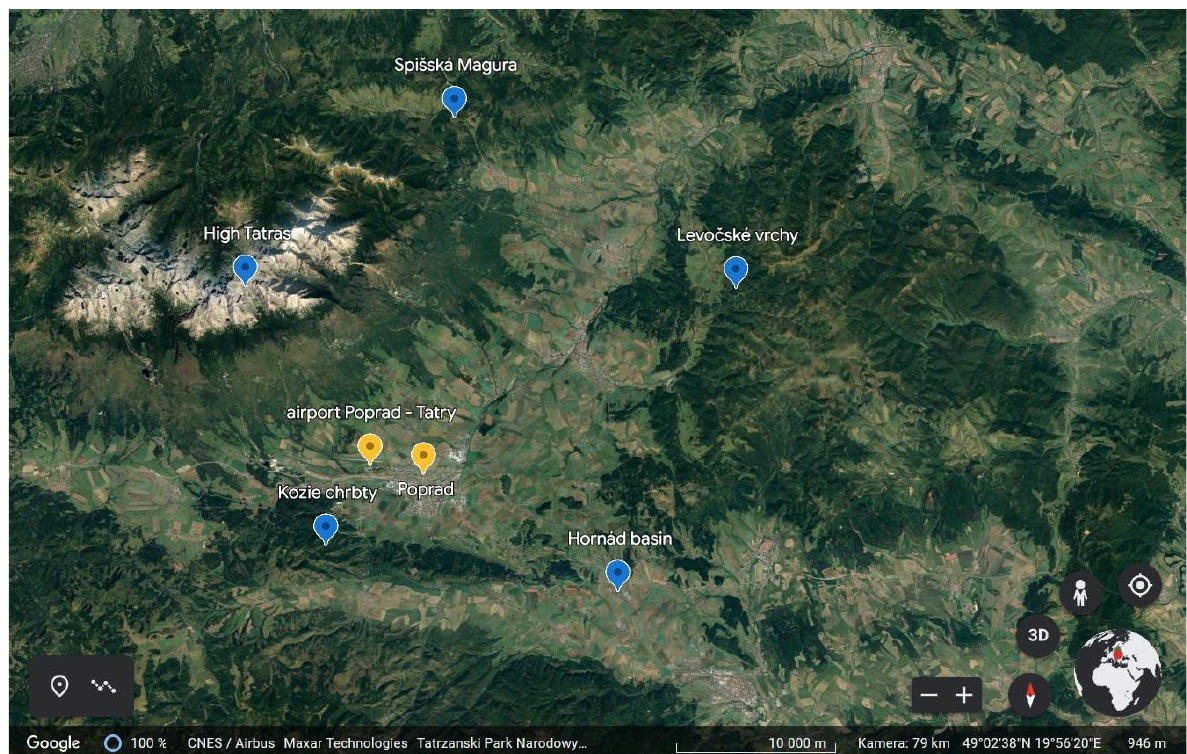
Figure 2. The topography of the Poprad basin and its surroundings. Source [54].